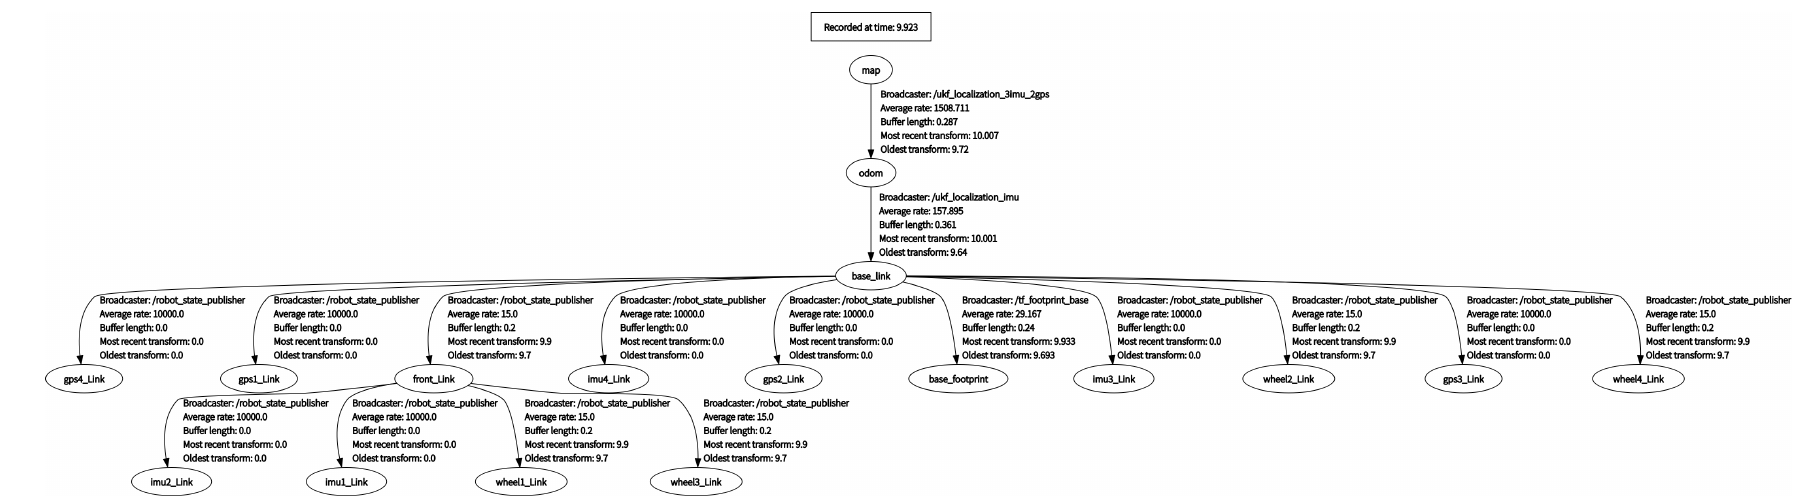
Figure 3. The dynamic system simulated by URDF file on